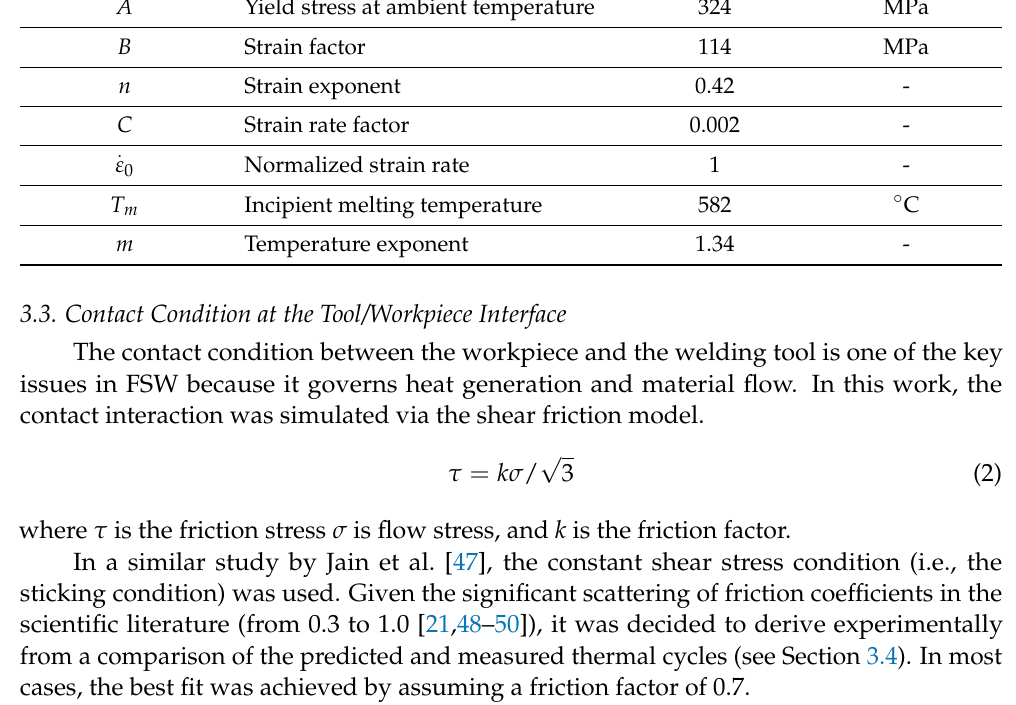
Table 2. Parameters of the Johnson–Cook equation used in numerical model. Parameter Definition Value